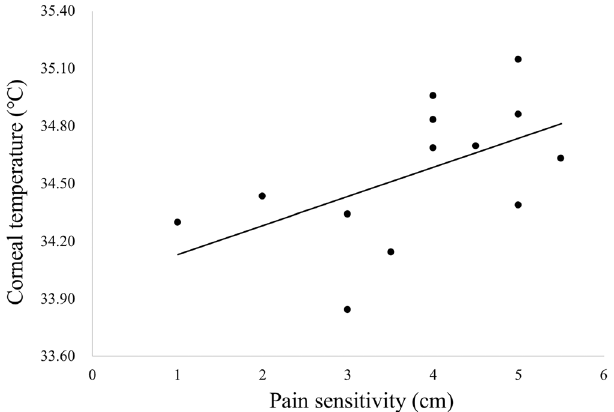
Figure 5. Association between corneal temperature with mask and pain sensitivity in MADE group (n = 13). Positive correlation was shown between the corneal temperature with mask and pain sensitivity (r = 0.5925, P < 0.05, Spearman’s rank correlation